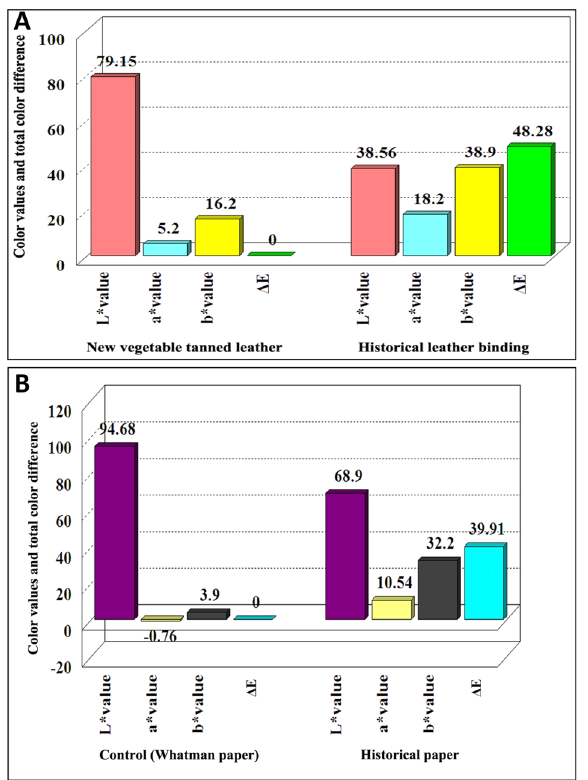
Fig. 5 Measurement of color changes for a historical manuscript under study. A is color change values of historical leather compared with control, B is the color change values of historical paper compared with Whatman No. 1 Table 1. Isolation and traditional identi fi cation of fungal communities associated with the historical manuscript (papers and leather bookbinding). Fungal code